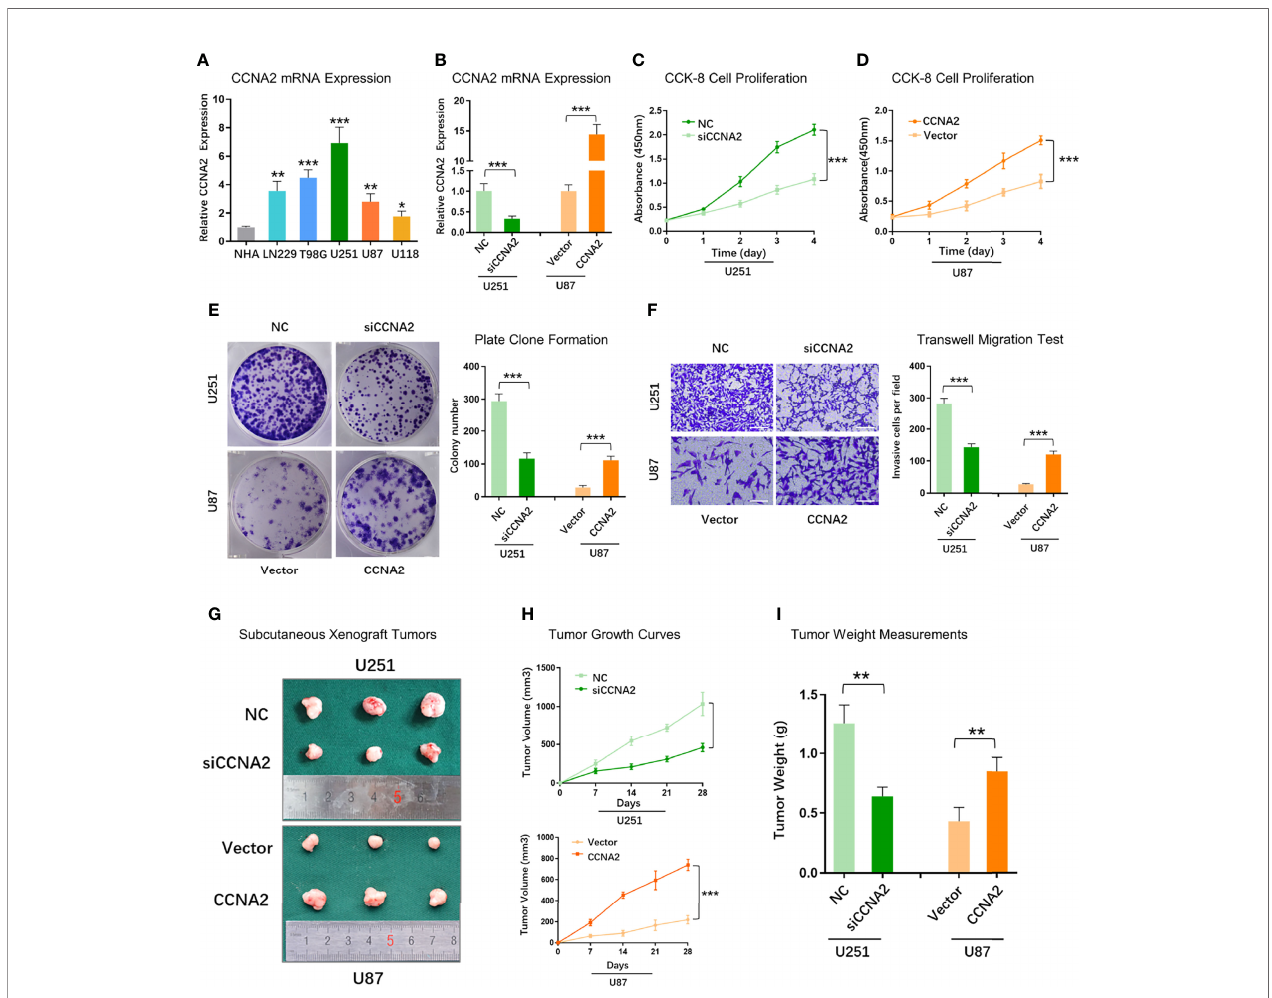
FIGURE 10 | CCNA2 promoted glioma cell proliferation and migration. (A) qRT-PCR of CCNA2 mRNA expression in NHA and glioma cells. (B) qRT-PCR of CCNA2 levels in U251 and U87 cells transfected with si-CCNA2 and CCNA2-cDNA. (C, D) CCK-8 of the cell growth curve in transfected U251 and U87 cells. (E) Colony assay in transfected U251 and U87 cells. (F) Transwell invasion test in transfected U251 and U87 cells. (G) Representative images of subcutaneous xenograft tumors implanted with U251-siCCNA2 and U87-CCNA2 cells. (H, I) Tumor volume and tumor weight of indicated xenograft models. * P < 0.05, ** P < 0.01, *** P <